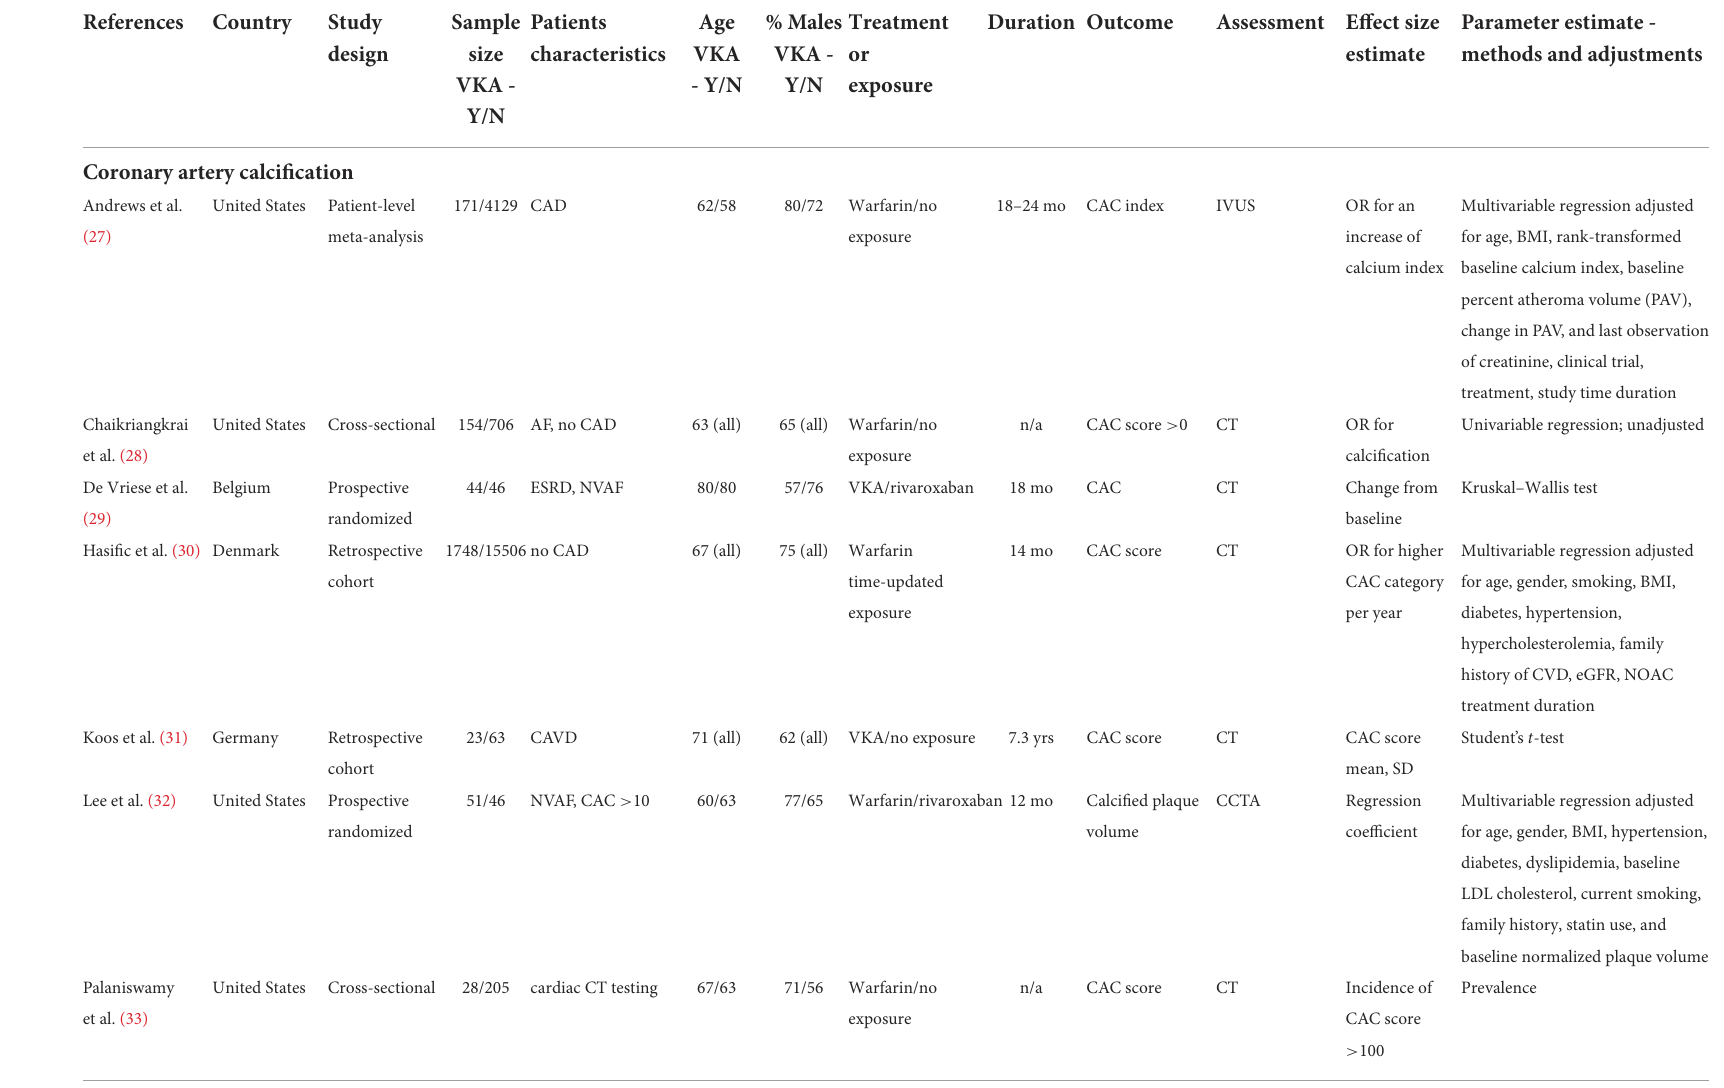
TABLE 1 Characteristics of the included